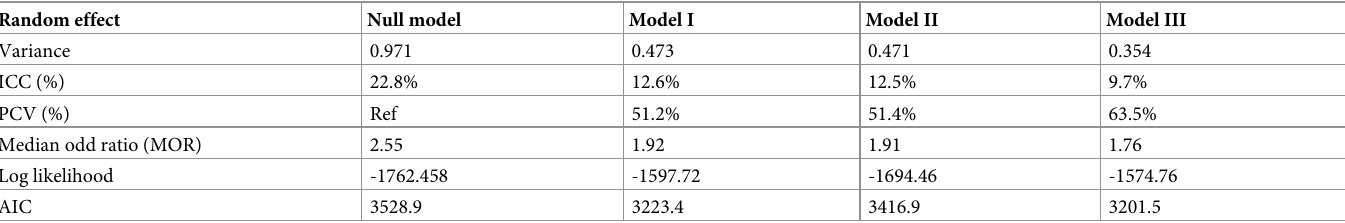
Table 1. Multilevel fixed effect model of individual and community level factors predicting postnatal care visit at home by health care professional in Ethiopia. Random